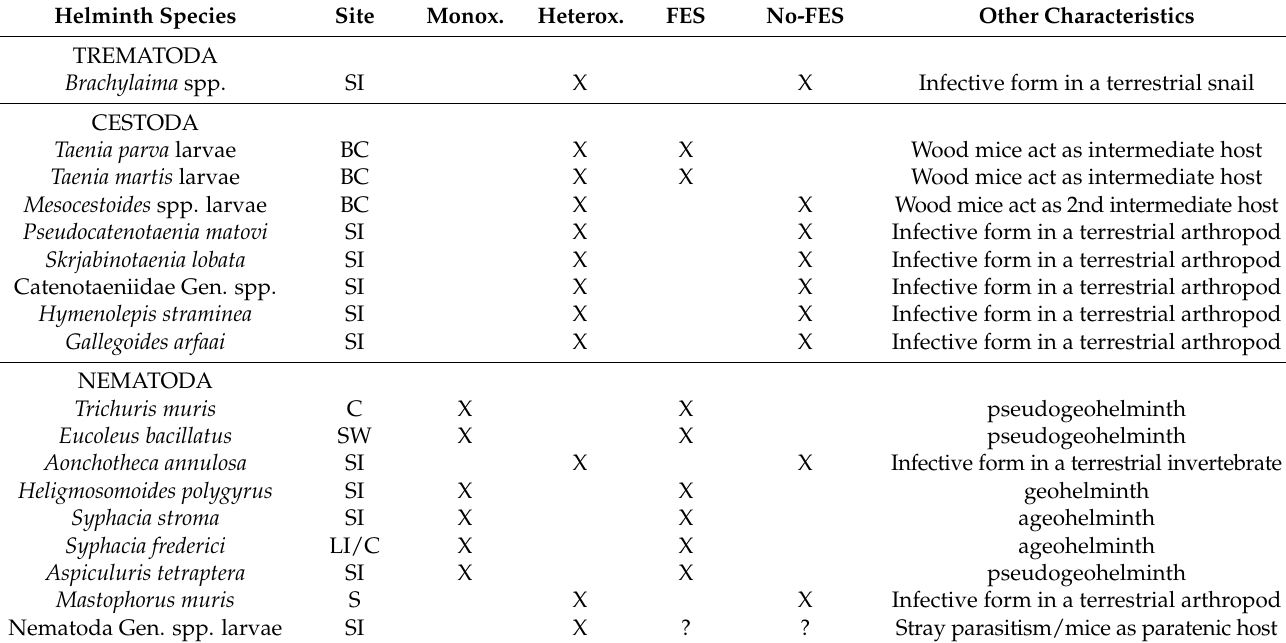
Table 4. Selected characteristics of the helminth community of 917 wood mice analysed from Serra Calderona Natural Park. Helminth Species Site